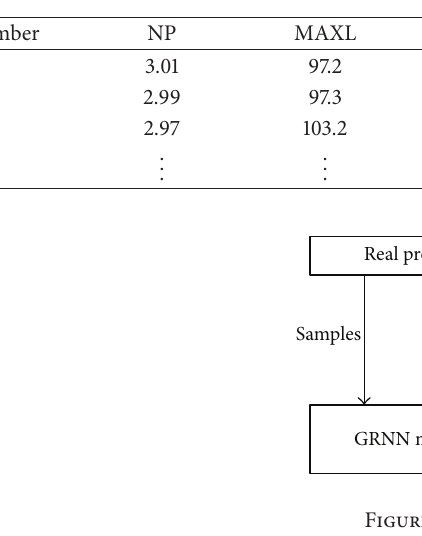
Table 2: Instances of experiment data from a certain oilfield.